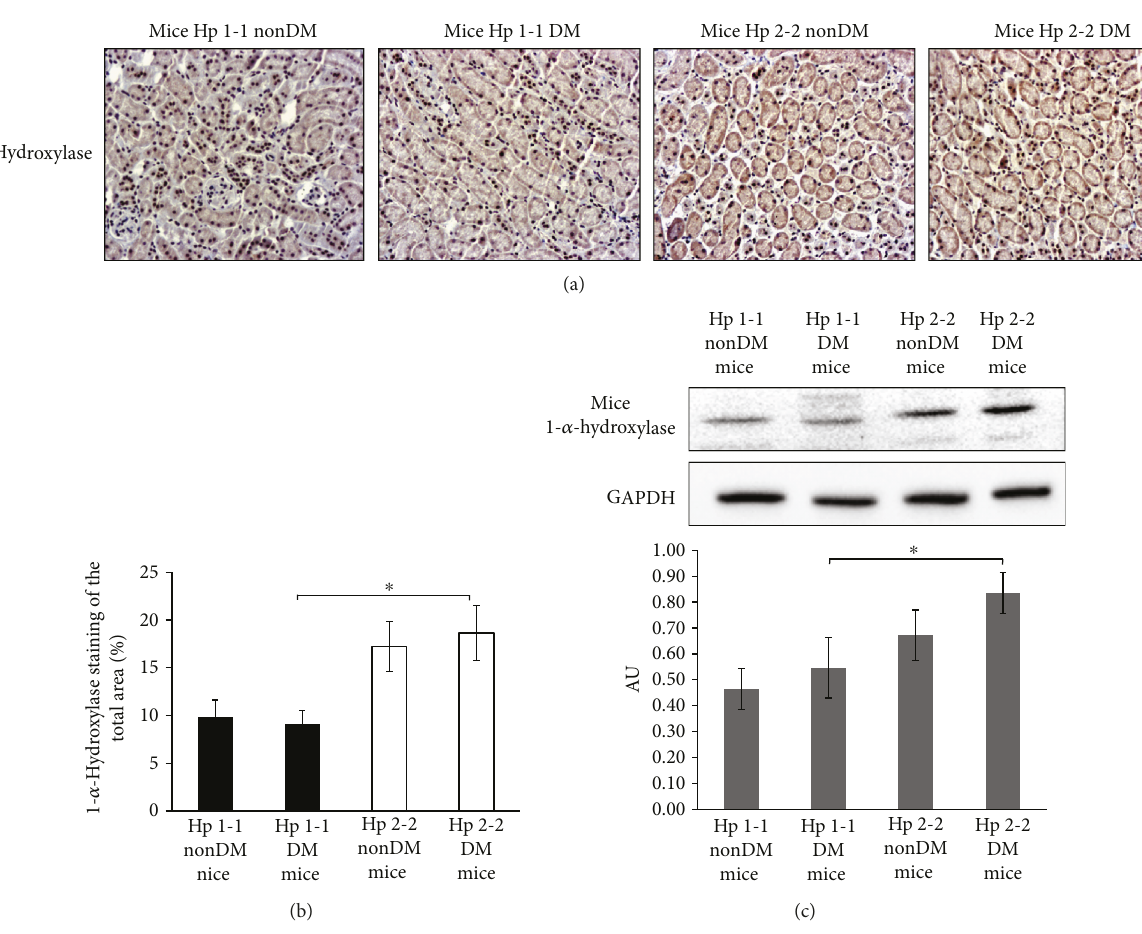
Figure 7: 1- α -Hydroxylase expression in diabetic and nondiabetic (nonDM) mice. (a) Slides from mice renal biopsies were subjected to IHC of 1- α -hydroxylase. (b) There was a signi fi cant increase in the percentage of the stained area of 1- α -hydroxylase in the tubules of Hp 2-2 DM renal sections compared with Hp 1-1 DM sections ( ∗ p < 0 05 ) but insigni fi cant compared with nonDM Hp 2-2 genotype. (c) Western blot analysis of 1- α -hydroxylase with the mice renal lysate. Proteins were detected by immunoblotting with antibodies against 1- α -hydroxylase and GAPDH. The values represent the mean ± SEM for 3 independent experiments subjected to 2-tailed, 2-sampled unequal variance Student ’ s t -test, with # p = 0 008 compared with Hp 1-1DM. AU: arbitrary